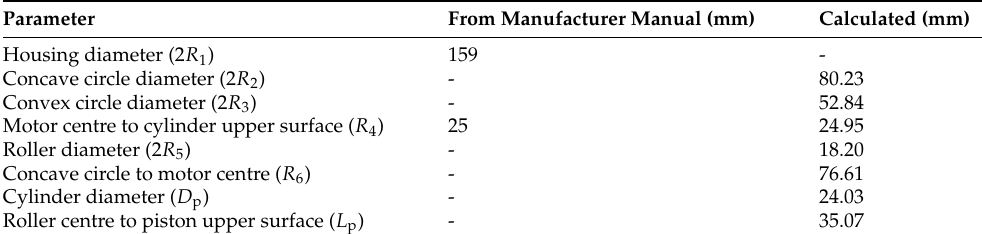
Table 1. Geometrical parameter values of the expander